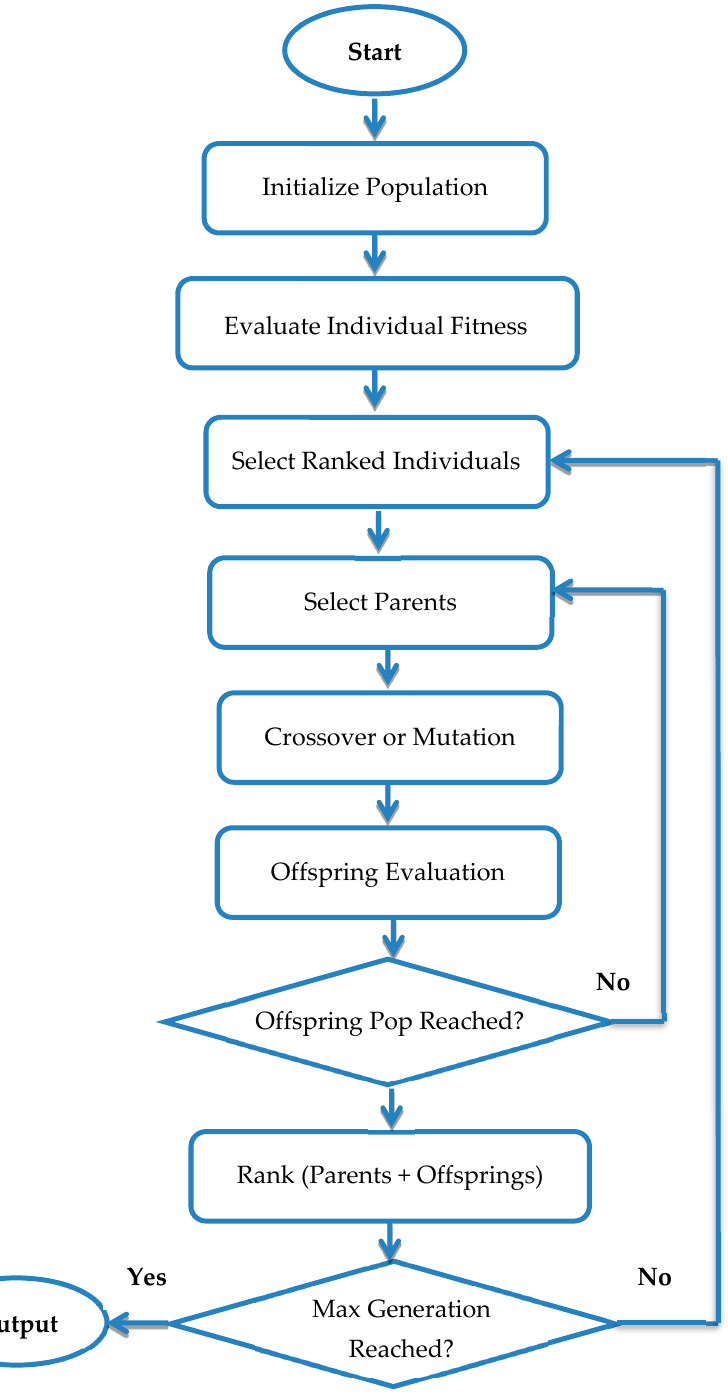
Figure 2. Non-dominated sorting genetic algorithm (NSGA)-II [32].